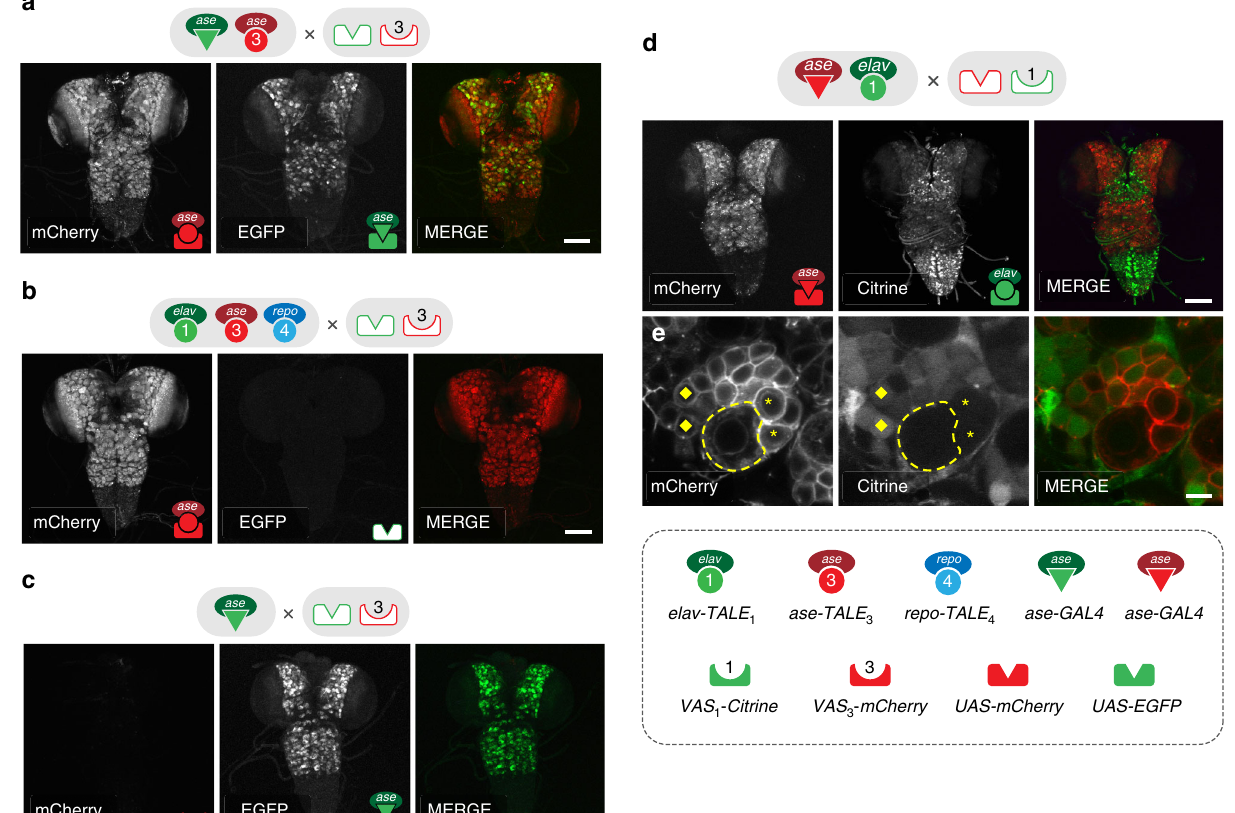
Fig. 4 Parallel delivery of TALE – VAS and GAL4 – UAS binary expression systems in vivo. a Analysis of mCherry and GFP expression in larval CNS neuroblast cells from ase 0.8kb -TALE 3 ; ase-GAL4 > VAS 3 -V5-mCherry; UAS-mCD8-GFP animals. b , c Orthogonal transgene activation by TALE – VAS and GAL4 – UAS systems. ase 0.8kb -TALE 3 speci fi cally activates VAS 3 - V5-mCherry in neuroblasts without driving expression of the UAS-mCD8-GFP transgene ( b ). Conversely, ase-GAL4 activated only the UAS-controlled mCD8-GFP transgene ( c ). d Simultaneous labelling of the neuroblast (mCherry) and neuronal (Citrine) compartments by combinatorial elav 1.8kb - TALE 1 ; ase-GAL4 > VAS 1 - Citrine-HA; UAS--mCD8-mCherry transgene expression. e Detail of a large neuroblast (dashed line) devoid of Citrine, surrounded by ganglion mother cells (asterisk) and differentiating neurons (diamond) gradually turning on Citrine expression. Scale bars = 100 µ m ( a – d ), 5 µ m ( e